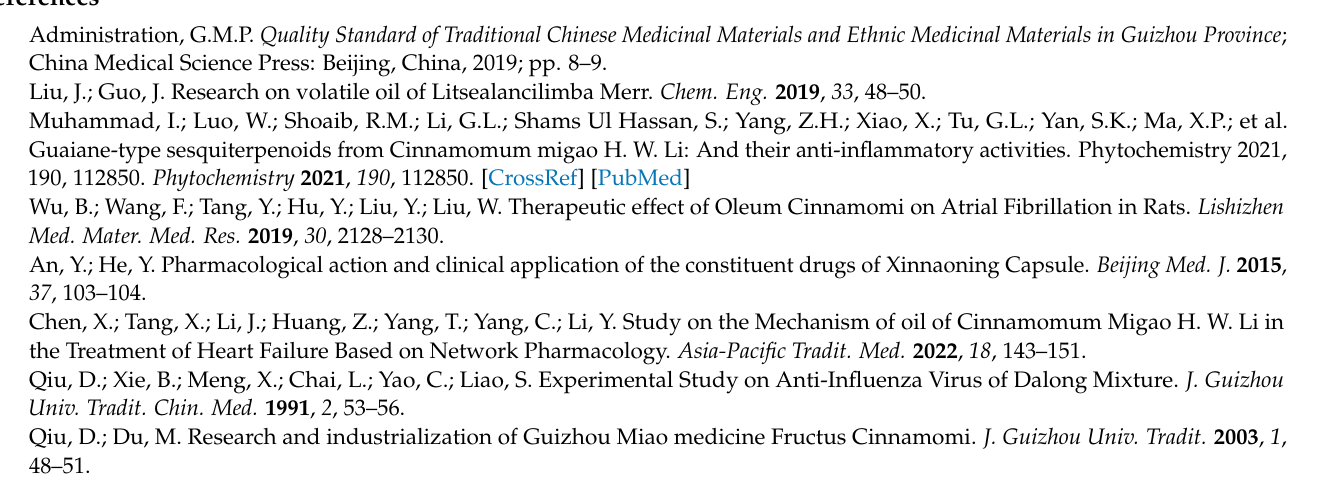
Figure sSEM3. Effect of soaking time on oil yield of Oleum Cinnamomi . Figure sSEM4. Effect of extraction time on oil yield of Oleum Cinnamom i. Tables and Figures. Table S1: Chemical-target gene database. Table S2: Disease-target gene database. Table S3: Target genes interacting with both chemicals and coronary heart disease. Table S4: The content of 10 ingredients in 20 batches of Oleum Cinnamomi (mg/g, n =3). Table S5: Sample information of Fructus Cinnamomi . Table S6: Ion information of multi-index components in Oleum Cinnamomi . Figure S1: GC-MS SIM chromatogram of reference solution (A), sample solution (B) and blank control solution